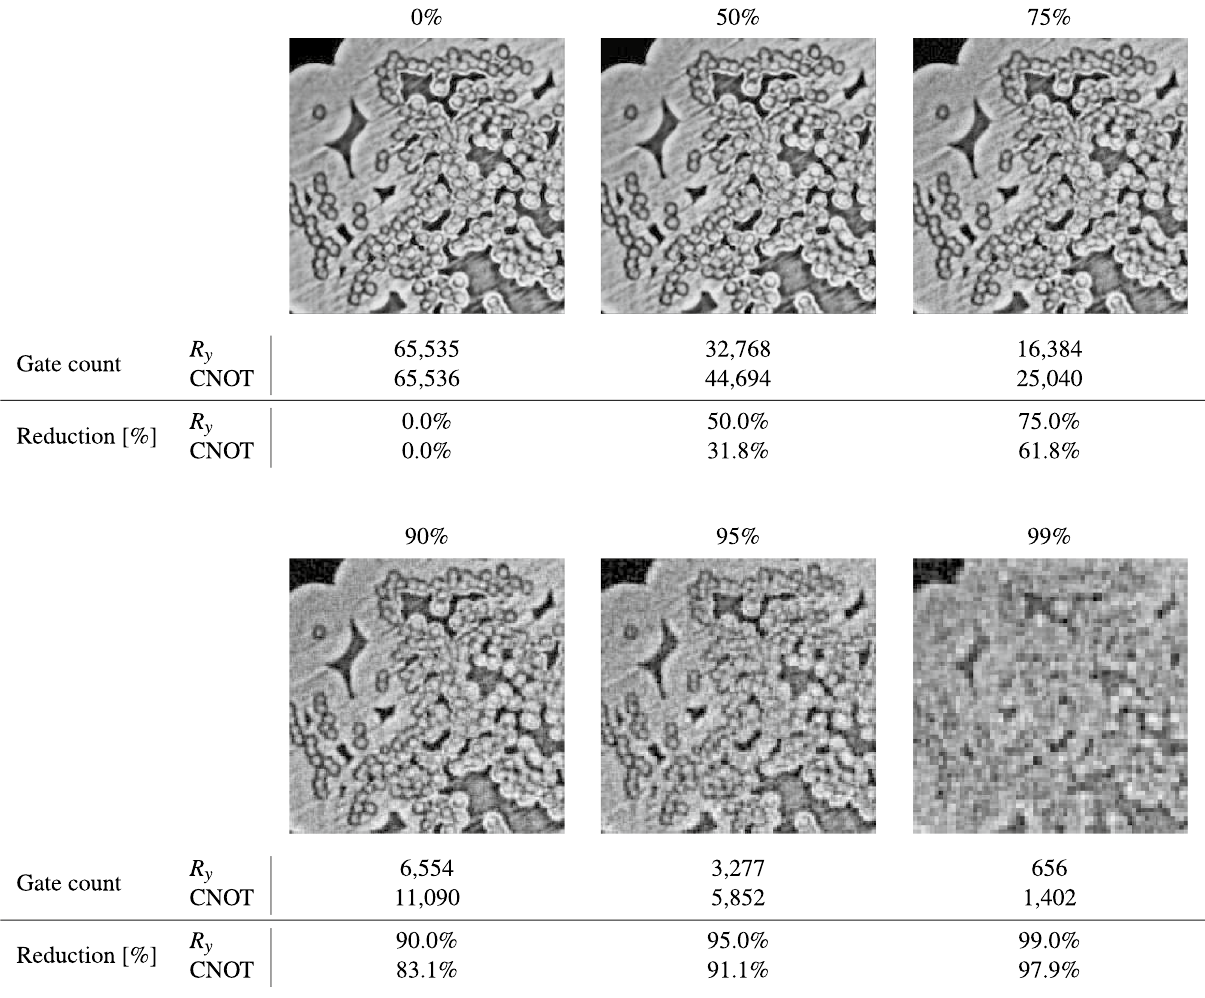
256 image data from of a ceramic matrix composite sample 49 acquired using microCT Figure 6. 256 × simulated with QPIXL++ at various compression levels and corresponding gate counts of the 17-qubit U R circuit. The final two rows list the reduction in R y and CNOT gates compared to the uncompressed